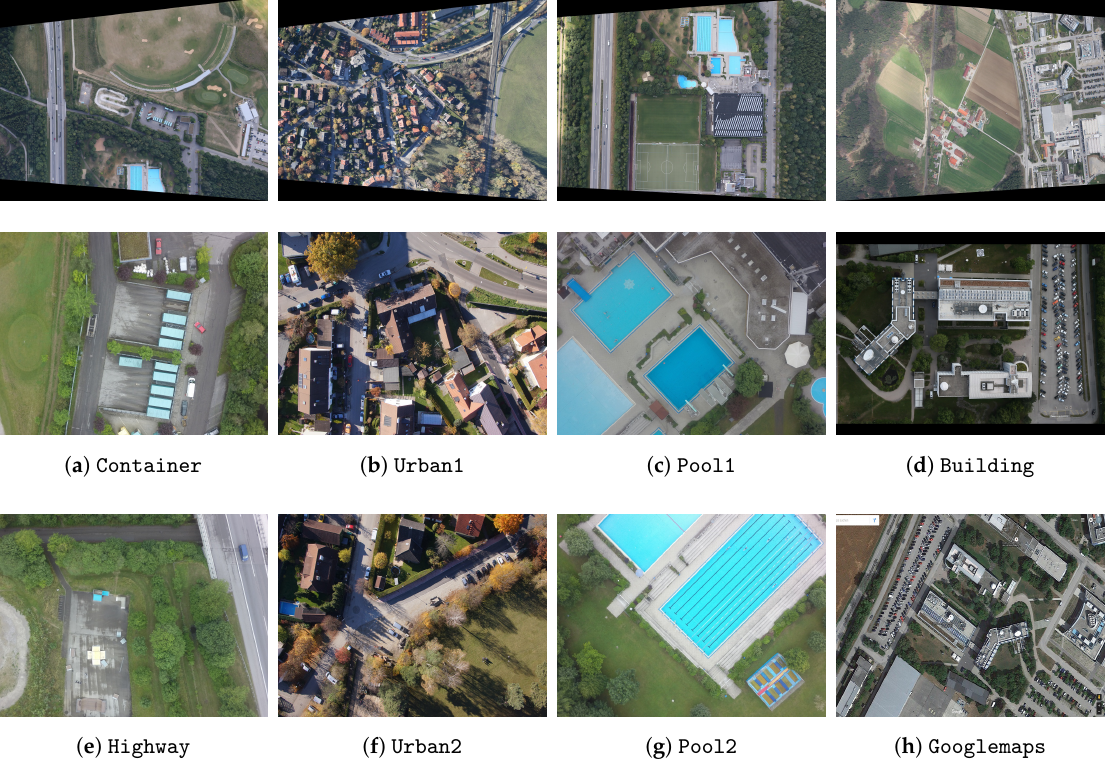
Figure 2. Datasets used in this paper: each column represents one (pre-processed) aerial reference image and two UAV target images. The UAV image in ( d ) should be matched to the aerial image (top right) and to a cropped part of a Google Maps image ( h ). ( a ) Container ; ( b ) Urban1 ; ( c ) Pool1 ; ( d ) Building ; ( e ) Highway ; ( f ) Urban2 ; ( g ) Pool2 ; ( h ) Googlemaps